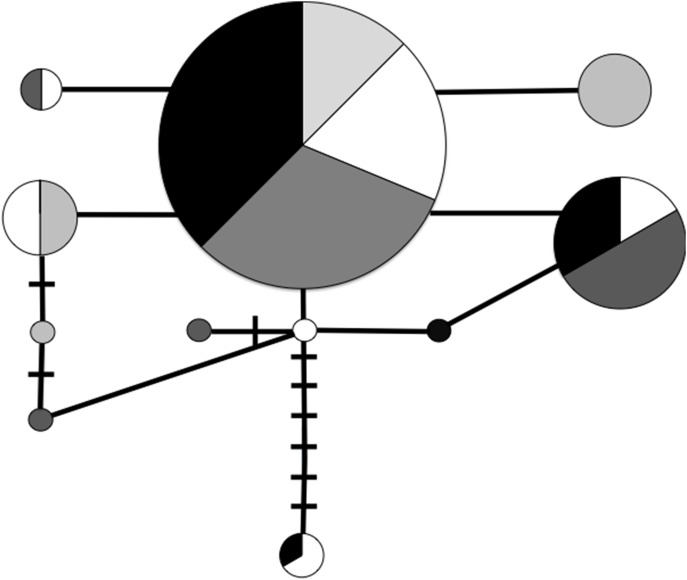
Network of 11 mitochondrial haplotypes of western tent caterpillars from Galiano and Westham Islands based on the intergenic spacer region and partial sequences of cytochrome oxidase I.Individuals from Galiano Island 2003 and 2011 are represented by light gray and white and those from Westham Island 2003 and 2011 are represented by dark gray and black, respectively. The size of each circle is proportional to the number of individuals. Lines connecting each haplotype correspond to a single nucleotide change and black lines represent a single unobserved nucleotide change between haplotypes inferred from parsimony analysis.